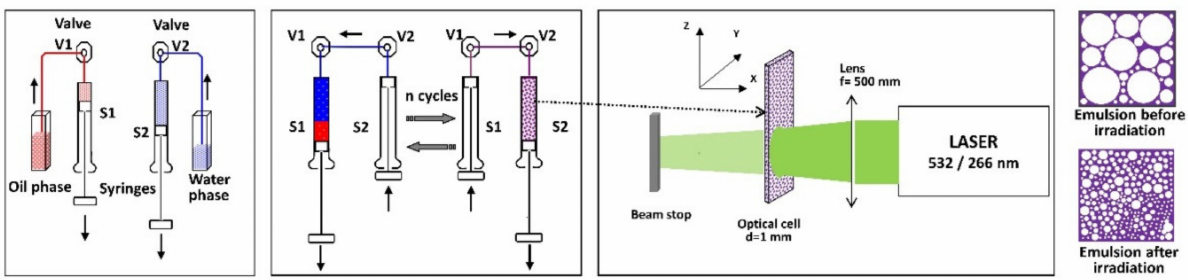
Figure 5. Principle of a new laser-assisted emulsification method. Step one: mixing of the continuous phase with the dispersed phase with a double syringe method. Step two: non-resonant interaction of the coarse emulsion with the laser